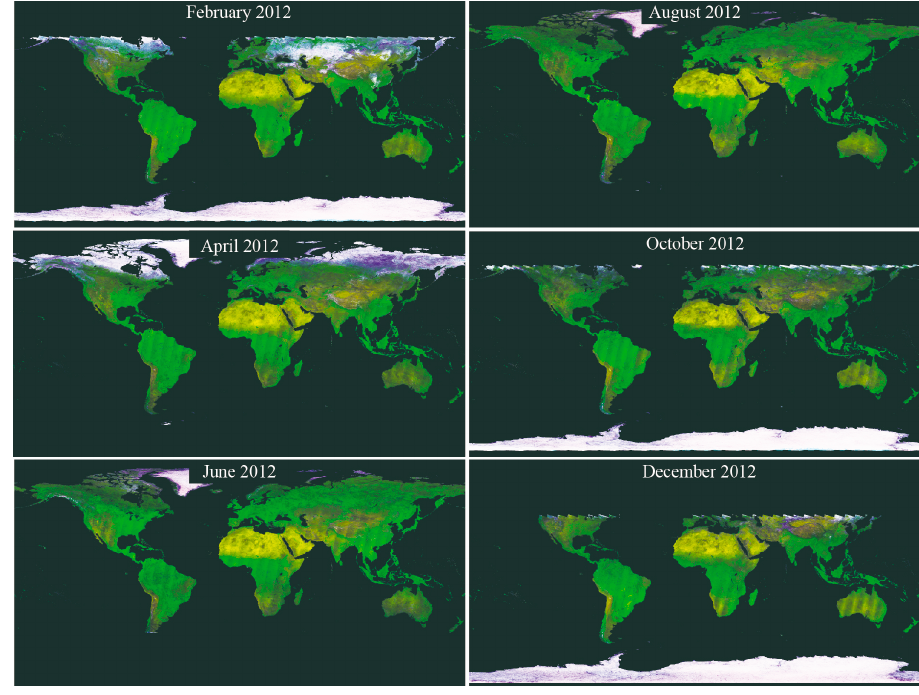
Figure 5. Change of global surface reflectance (R: Band 2; G: Band 3; B: Band 1).